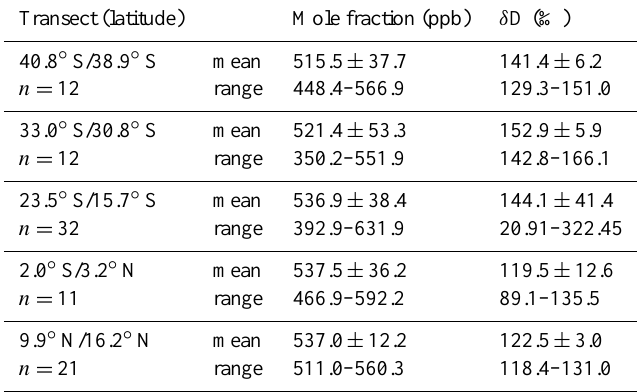
Table 3. Overview of means of atmospheric H 2 and its isotopic composition along the five high–resolution transects of ANT-XXV/5, including the standard deviation and the